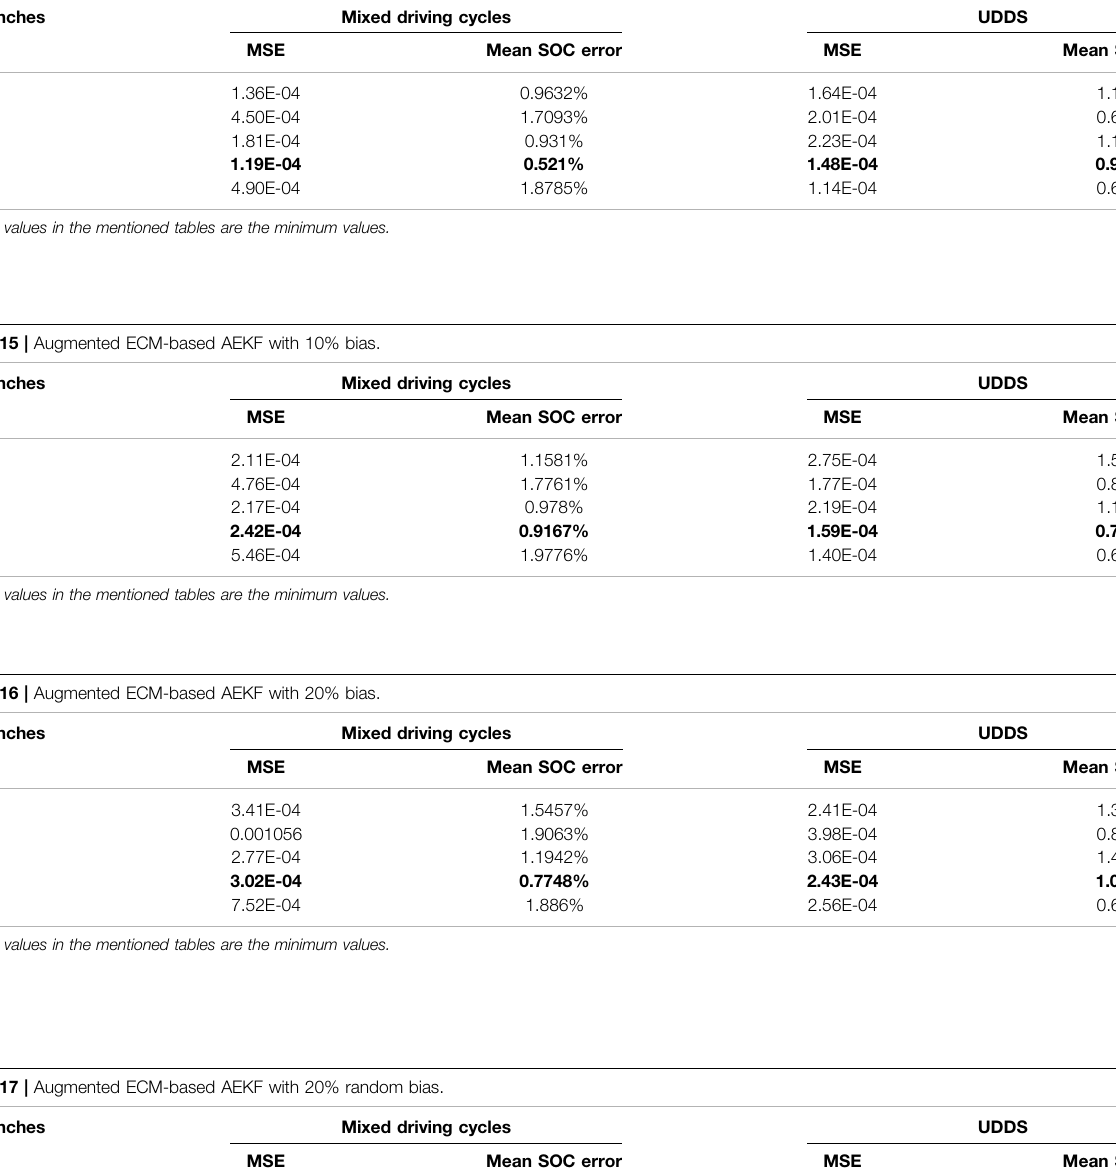
TABLE 14 | Augmented ECM-based AEKF with 5% bias. RC branches